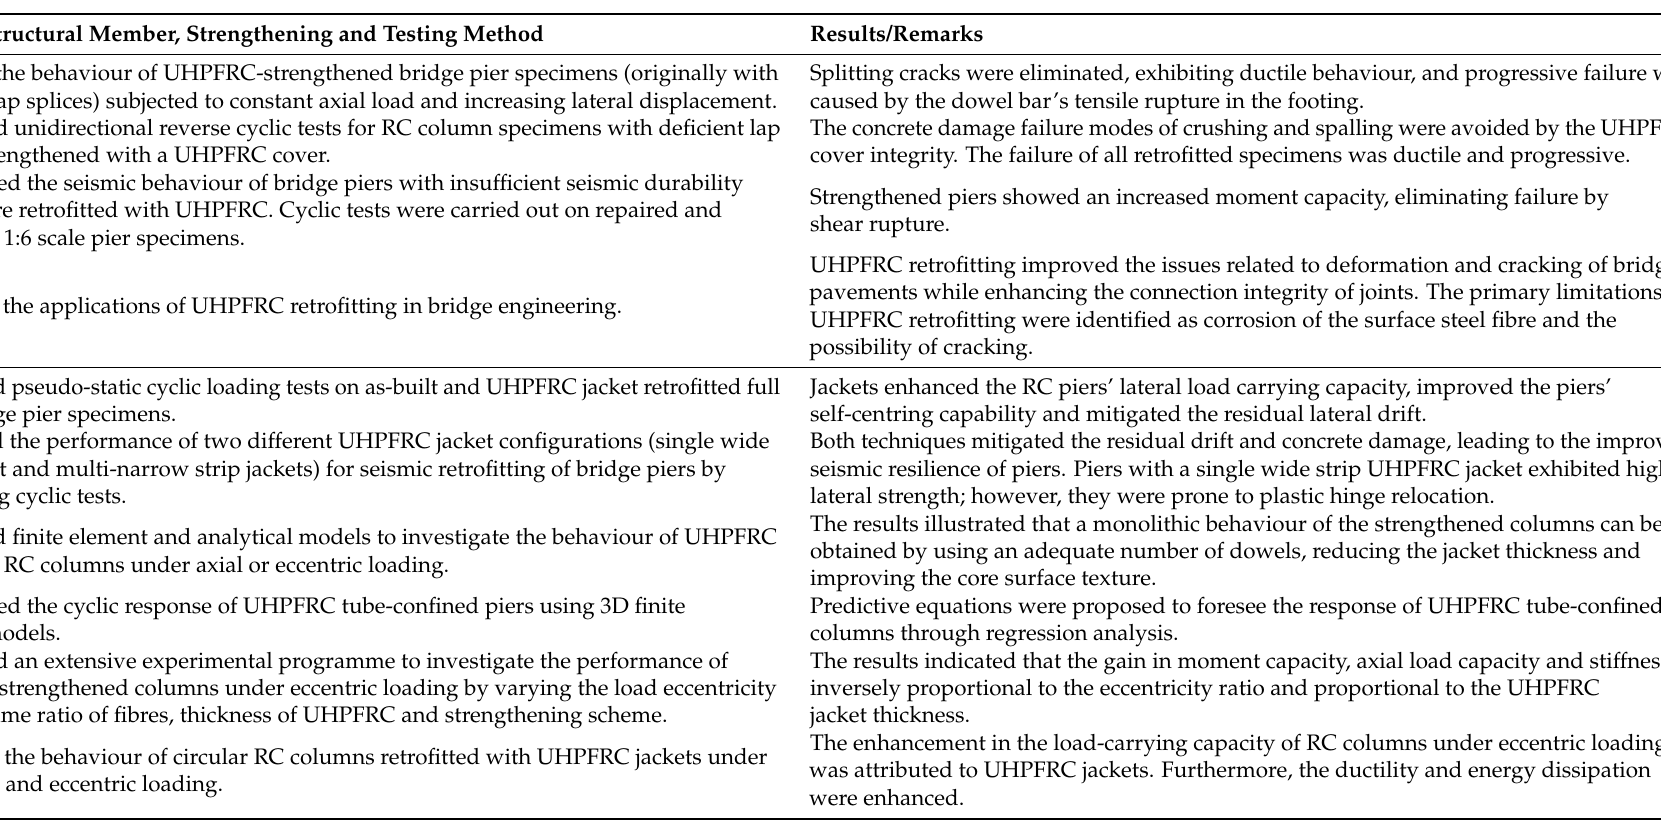
Table 3. Summary of the studies on combined axial and flexural strengthening using